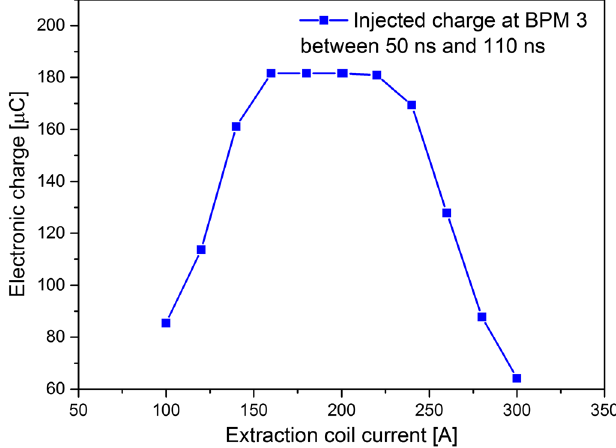
FIG. 9. Simulated electronic charge at BPM 3 integrated over 50 and 110 ns corresponding to the quasiflat part of the voltage pulse.